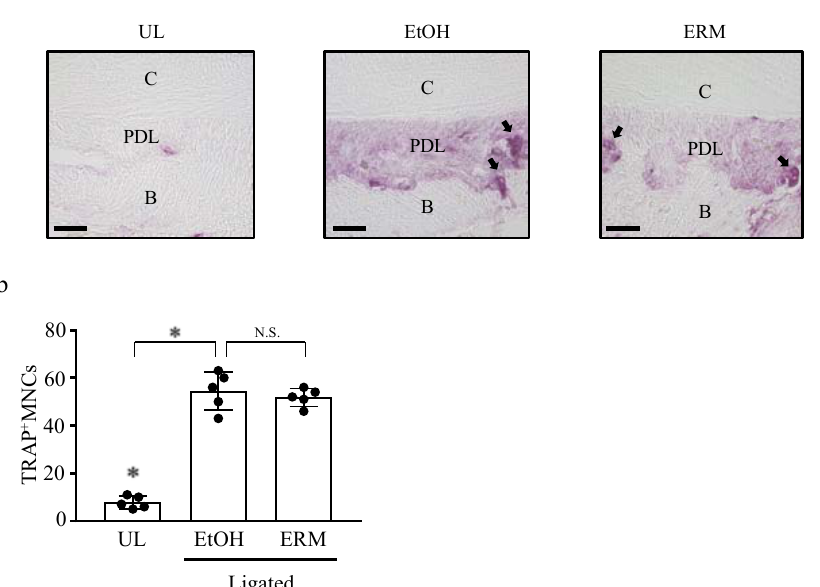
Figure 6. Erythromycin fails to inhibit ligature-induced osteoclast differentiation in Del1 − / − mice. ( a , b ) Frozen maxillae sections were stained with tartrate-resistant acid phosphatase (TRAP). ( a ) Representative images obtained by optical microscopy are shown; arrows indicate TRAP + osteoclasts. ( b ) TRAP-reactive multinucleated cells (MNCs) were counted in five coronal sections of ligated sites of each mouse. Scale bars, 50 µm. * p < 0.05 compared to ligated + ethanol (EtOH) group, means ± SD ( n = 5 per group). N.S., not significant.